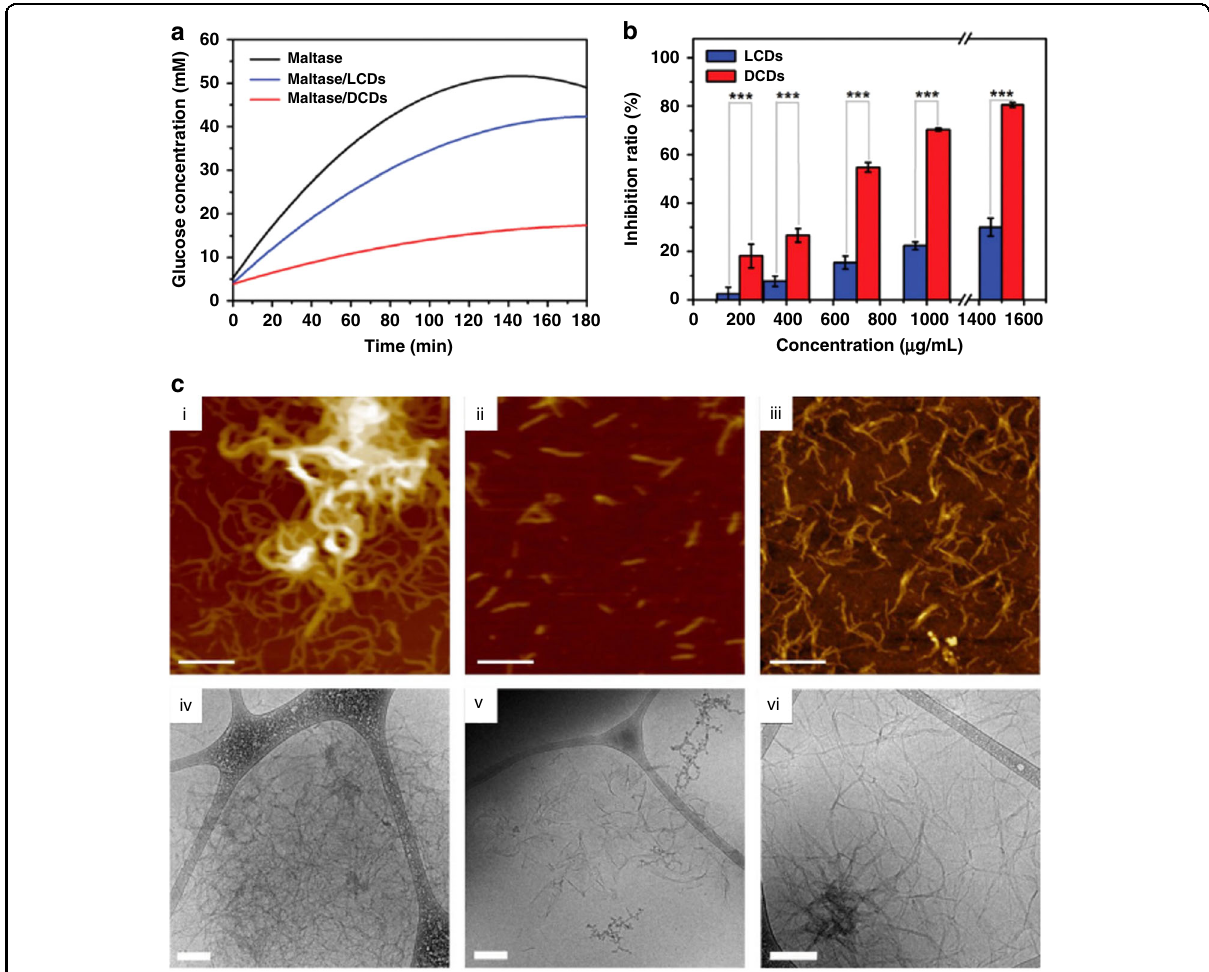
Fig. 10 Examples of catalysis and inhibition with chiral carbon dots. a Glucose concentration resulting from the maltose degradation for maltase (black line), maltase/L-glutamic acid capped CDs (LCDs, blue line), and maltase/D-glutamic acid capped CDs (DCDs, red line) at different hydrolysis times, and b inhibition ratio of LCDs (blue trace) and DCDs (red trace) with different concentrations after 90 min reaction. c Inhibition of prion peptide fi bril assembly with L-/D-lysine derived chiral carbon dots: (i – iii) AFM and (iv – vi) cryo-TEM images of the assembly on silicon wafer in the absence of carbon dots (i, iv), in presence of L-lysine-based carbon dots (ii, v), and in presence of D-lysine-based carbon dots (iii, vi). Bars correspond to 200 nm. a, b Adapted with permission from 68 Copyright 2019 Wiley-VCH GmbH. c Adapted with permission from 145 Copyright 2018 Wiley-VCH